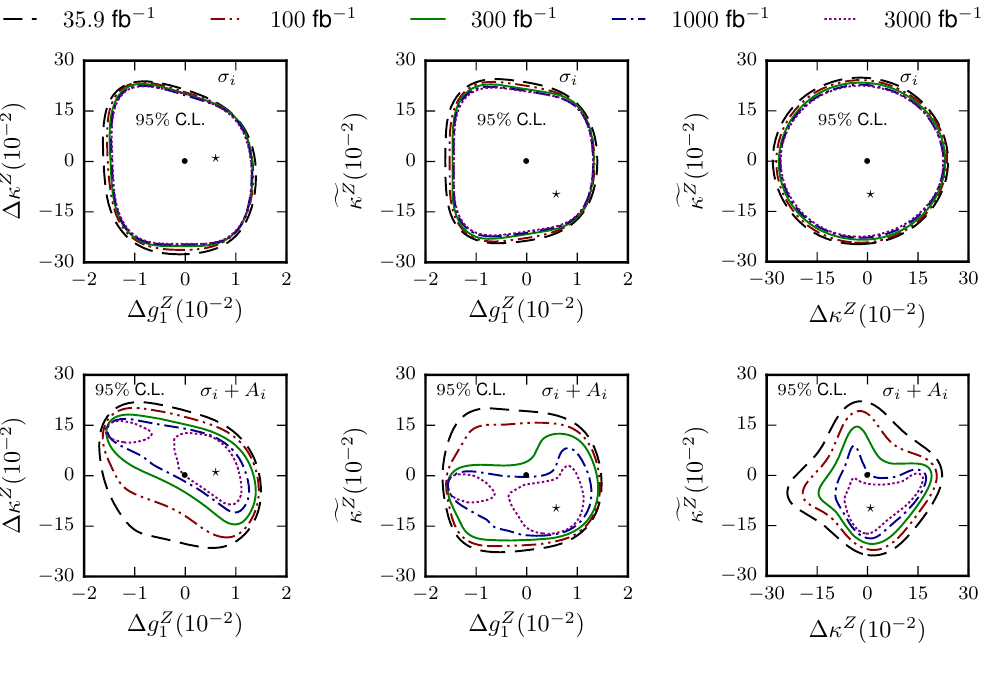
Figure 12 . The marginalised 2 D projections at 95 % BCI on (cid:1) g Z